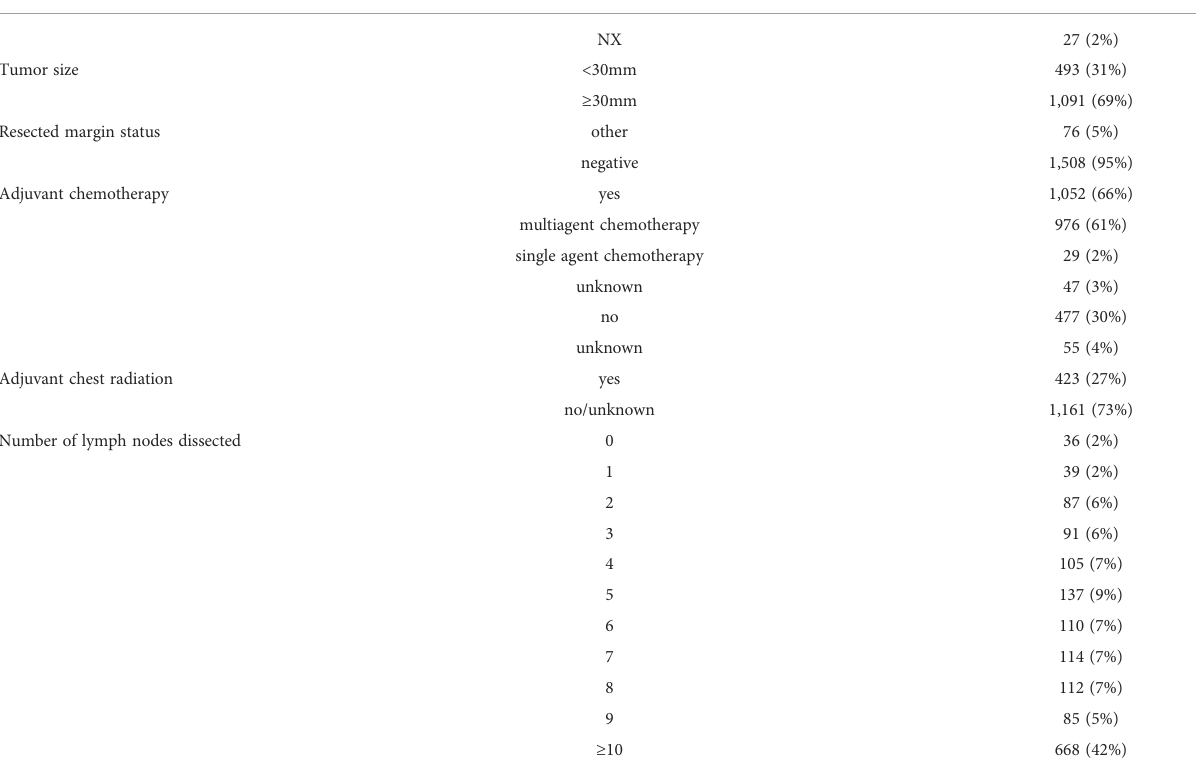
Figure 2. The OS was not signi fi cantly in fl uenced by the number of LNDs (P = 0.1194). Multivariable COX regression analysis in subgroup-by-subgroup comparisons according to LNDs was performed to fi nd the appropriate cut point. Figure 3 shows the hazard ratios [HR] for death by the number of LNDs. The sequential improvement in the HRs was no longer evident if the number of LNDs exceeds 4. A minimum of 3 LNs evaluation was needed to improve the mortality risk over compared with that without LNDs. As shown in Figure 4, patients with ≥ 3 LNDs had a signi fi cantly longer OS than those with <3 LNDs (median OS: